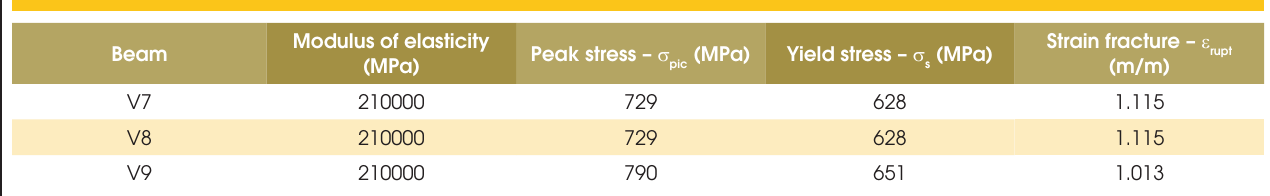
Table 18 – Longitudinal reinforcement data used in the modeling of beams tested by Oliveira